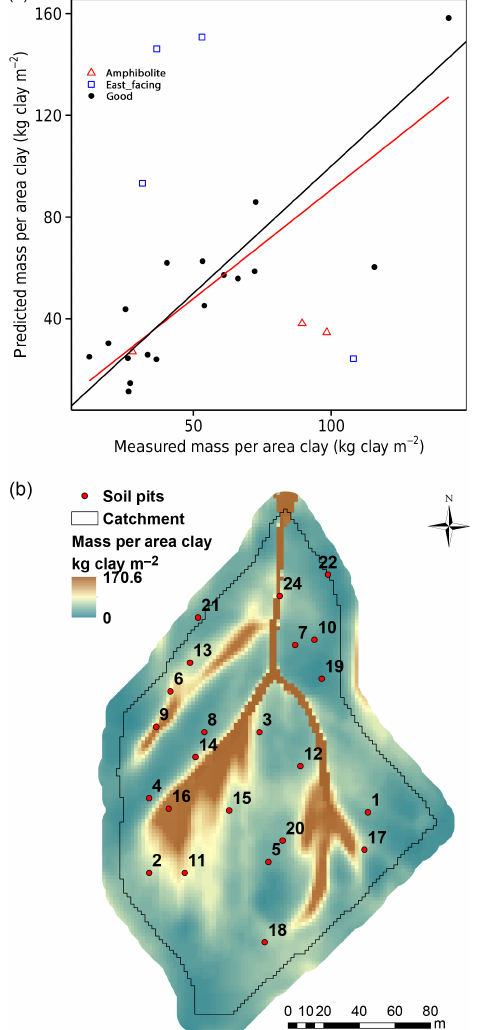
Figure 8. Model results of coupled geomorphic–EEMT–TPE model in Marshall Gulch granite sub-catchment. (a) Prediction of mass per area clay for sites from Holleran et al. (2015) and Lybrand and Rasmussen et al. (2015); (b) spatial prediction of mass per area clay. When combining the present approach, with a geomorphic- based soil depth model, the combined models together were highly effective at predicting the clay contents for a majority of soils in the Santa Catalina Mountains (Catalina-Jemez CZO), r 2 = 0 .